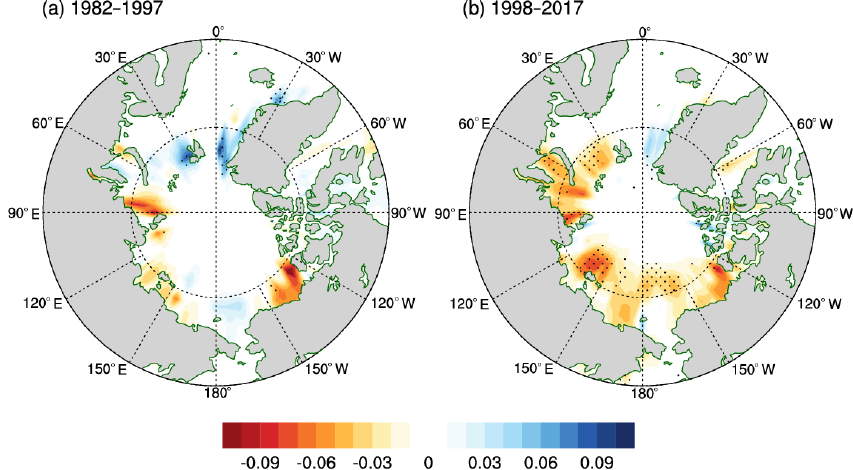
Figure 8. Surface albedo changes associated with the summer AD in (a) the past (1982–1997) and (b) the recent (1997–2017) periods, respectively. The AD index is reversed in sign before